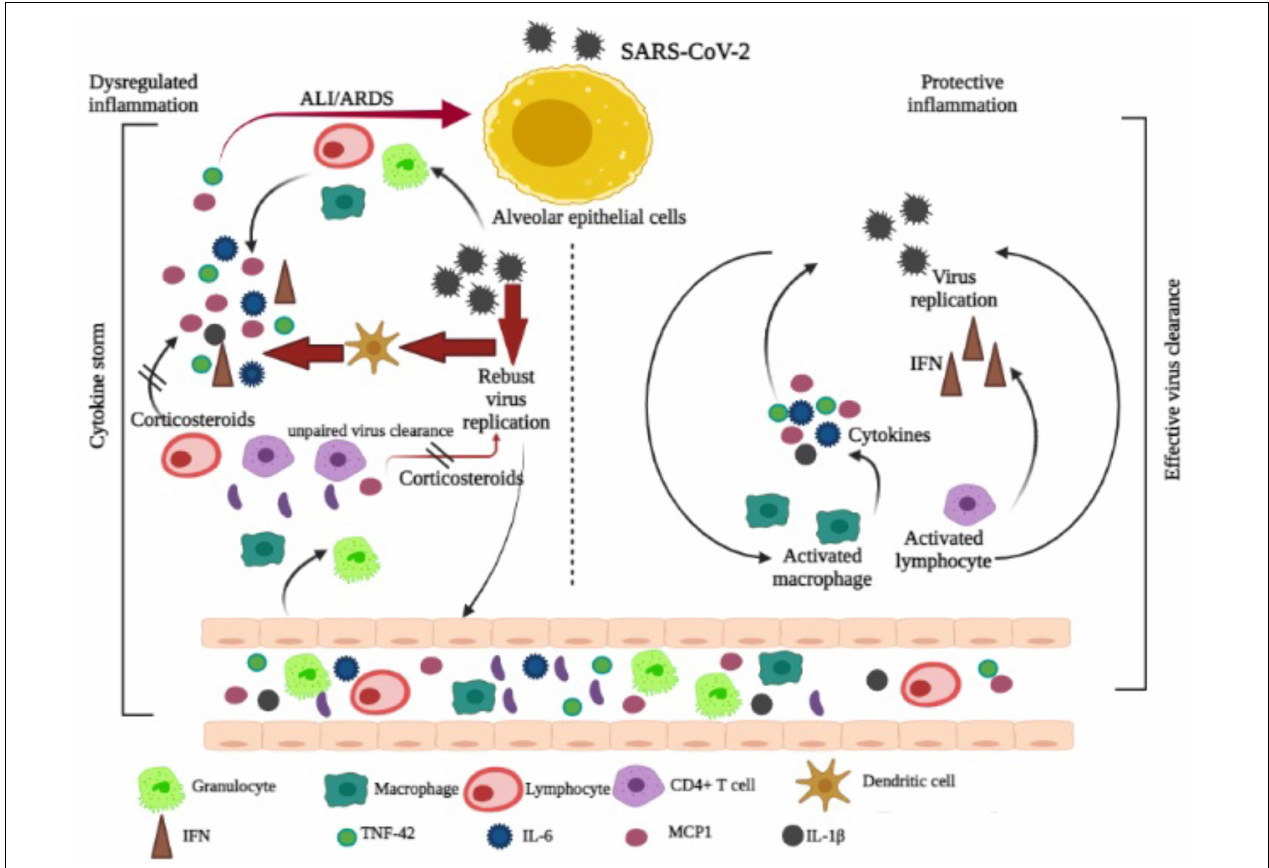
FIGURE 4 | Mechanism of COVID-19 and corticosteroid action is adapted and modified from Yang Yang J.W. et al.